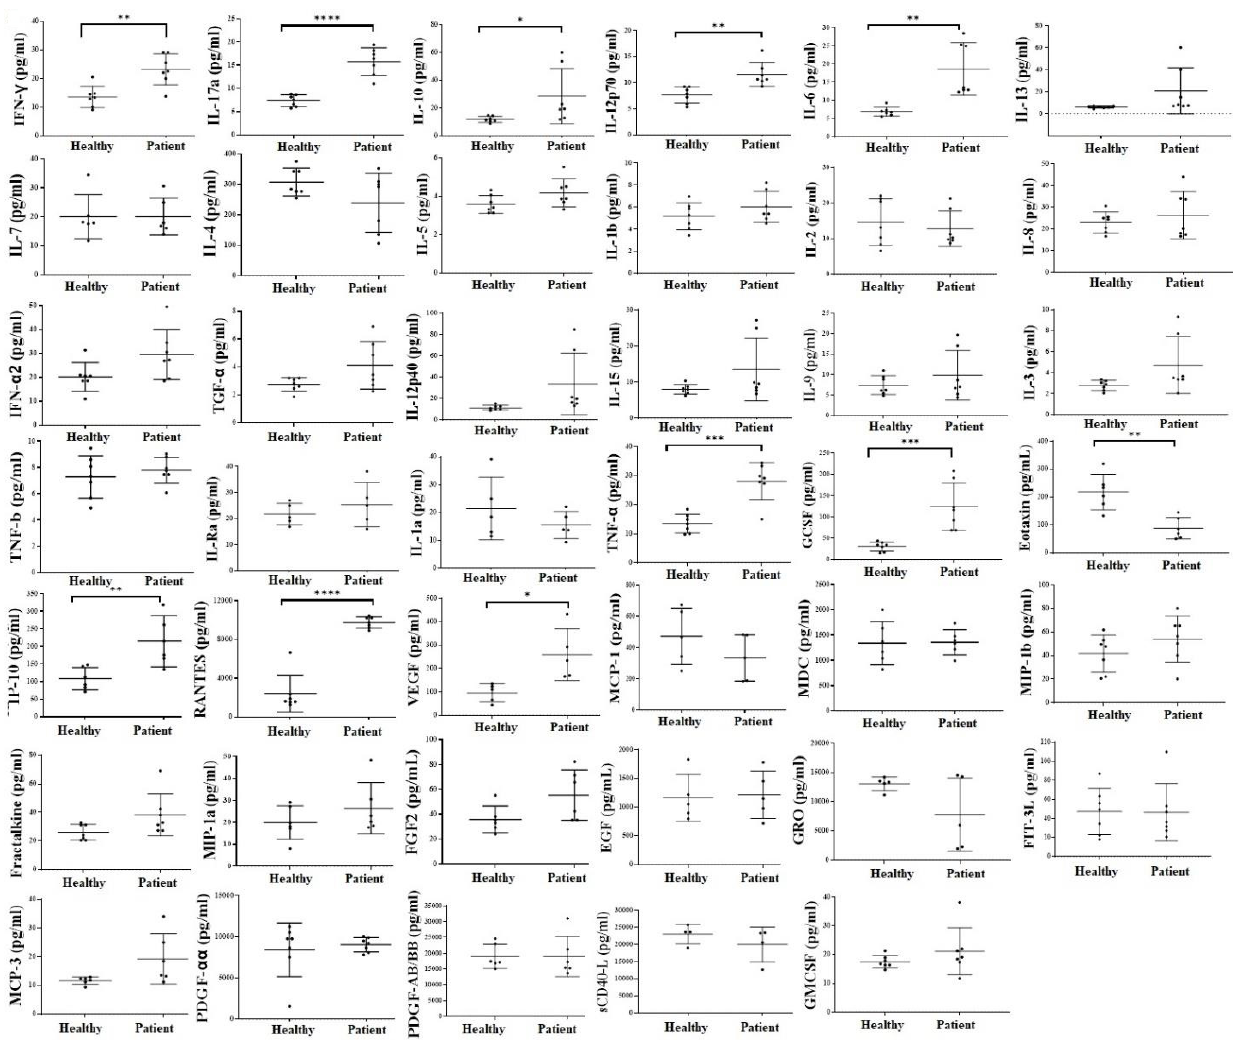
Figure 6. Inflammatory cytokines in the peripheral blood-derived serum of ALS patients in com- parison to those from healthy individuals. Sera were obtained from the peripheral blood of healthy individuals and ALS patients, and analyzed for the levels of cytokines, chemokines, and growth factors using a multiplex array kit ( n = 7). **** ( p -value < 0.0001), *** ( p -value 0.0001–0.001), ** ( p -value 0.001–0.01), * ( p -value